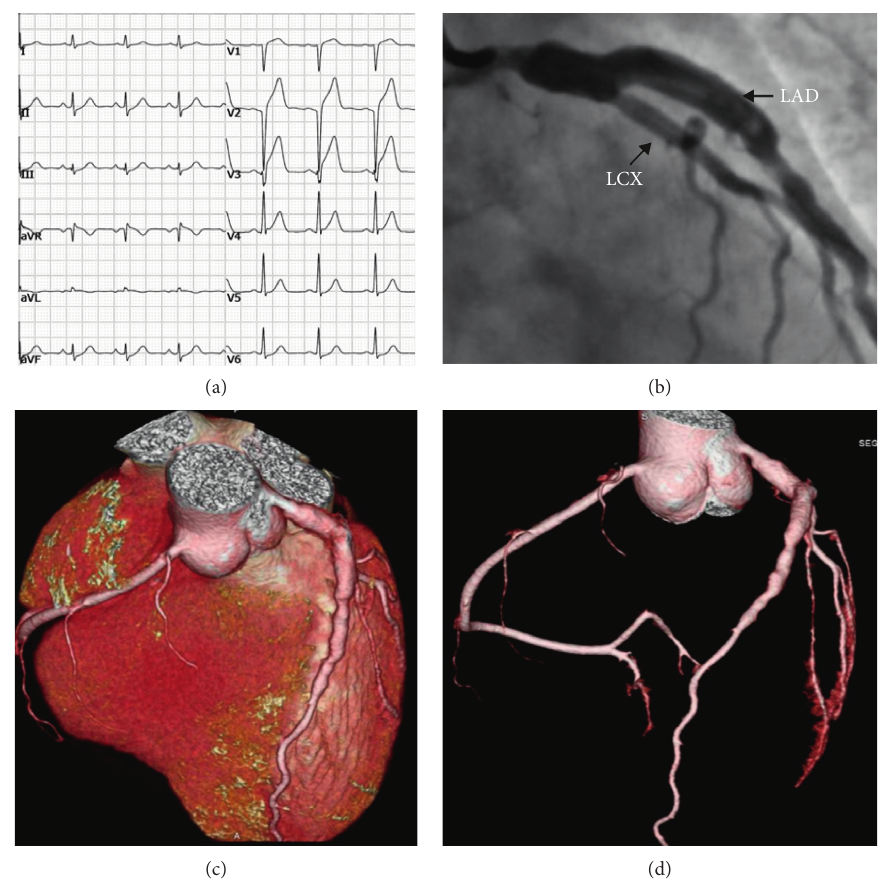
Figure 1: (a) ECG on admission: normal sinus rhythm with STsegment elevation on leads V1–3. (b) CAG: an aneurysmal dilatation from the LMCA to the proximal segment of LAD with a transverse diameter of 8.5mm. (c, d) Coronary CTA with three-dimensional volume rendering: multiple aneurysms from the LMCA to the proximal segment of the LAD